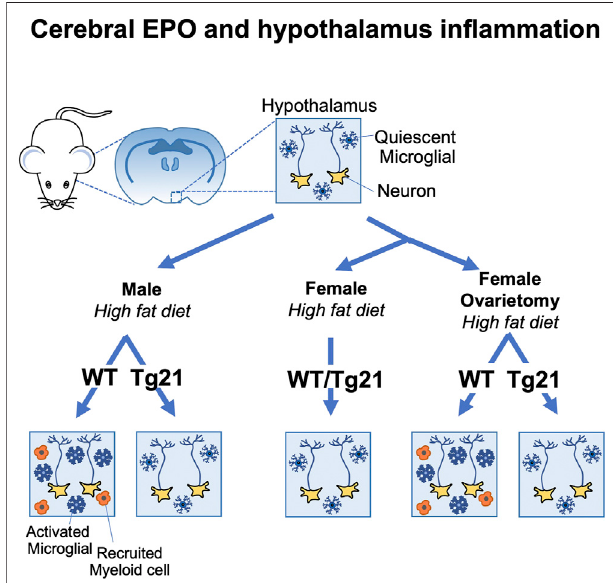
FIGURE 3 | Brain erythropoietin reduction of hypothalamus in fl ammation during high fat diet induced obesity in mice is sex-speci fi c. Male wildtype(WT)(C57BL/6)micefedhighfatdietshowincreasedin fl ammationin the arcuate region of the hypothalamus with increase